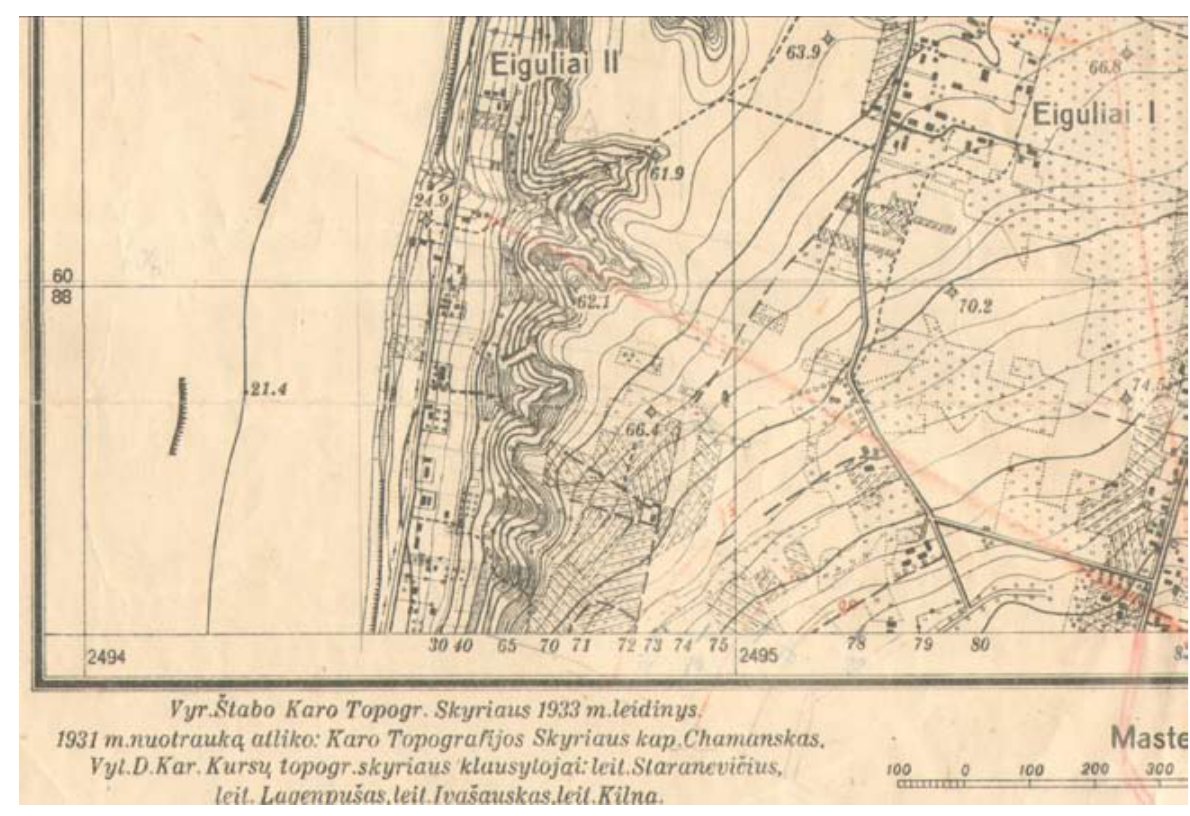
Fig. 5. Fragment of Kaunas garrison shooting-theatre map, scale 1:100